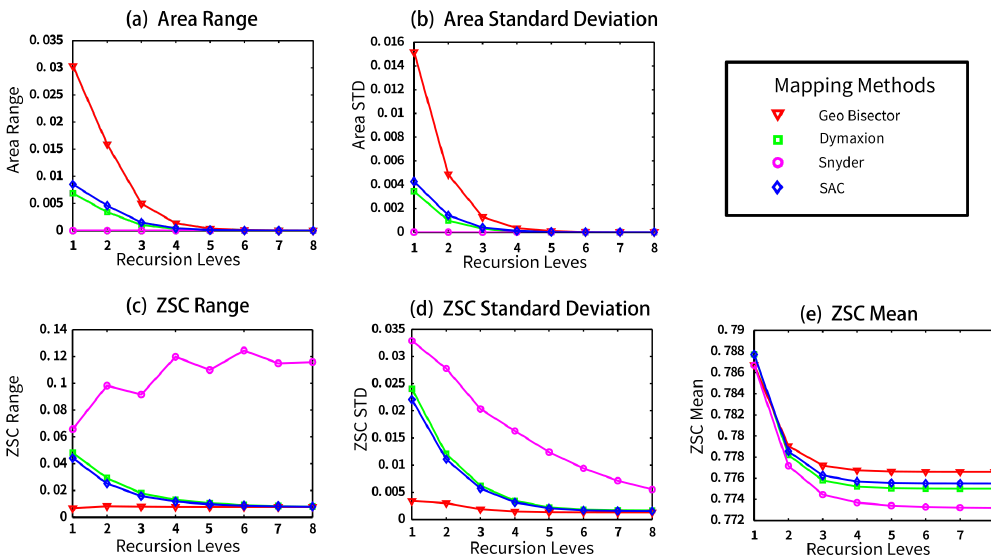
Figure 19. Graphs of the five statistics of the area and ZSC response measurements for each method as a sequence by recursion level (level 1 to level 8). These results are for the icosahedron using the 4-fold density ratio.